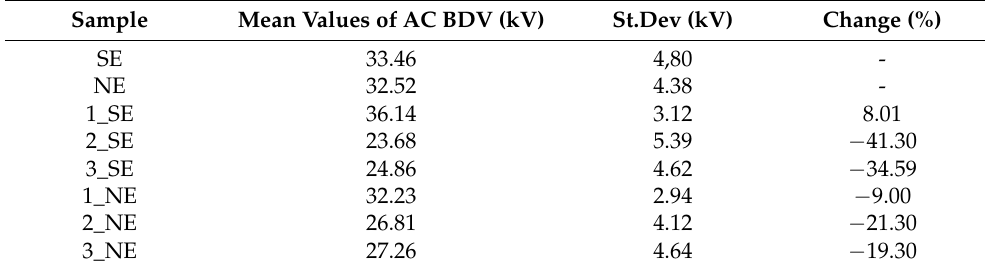
Table 3. Mean values, standard deviation, and change of examined